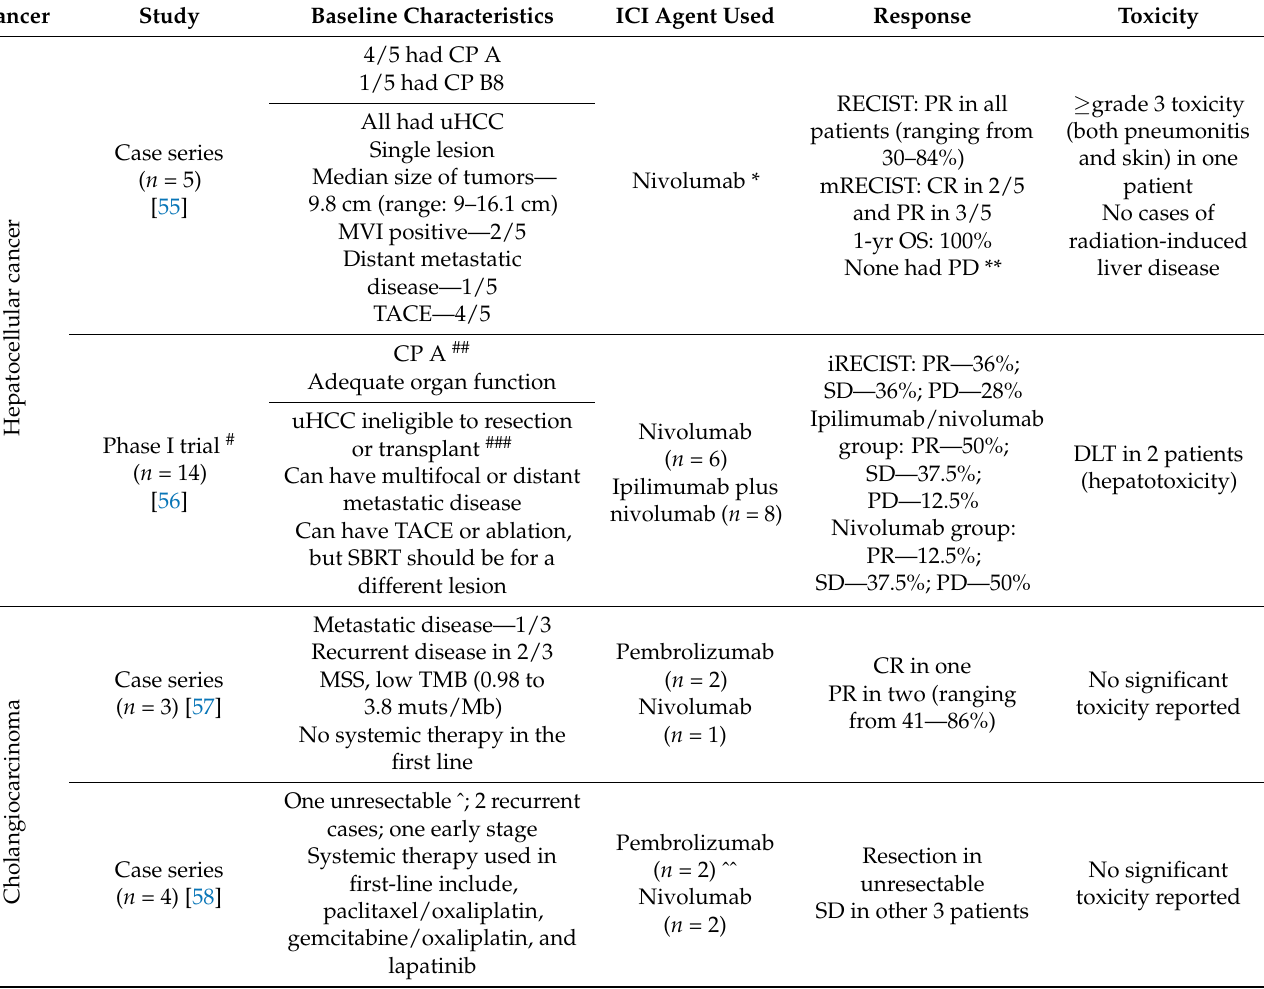
Table 1. Available Evidence on Stereotactic Body Radiation Therapy and Immune-Checkpoint Inhibitors in Hepatocellular Carcinoma and